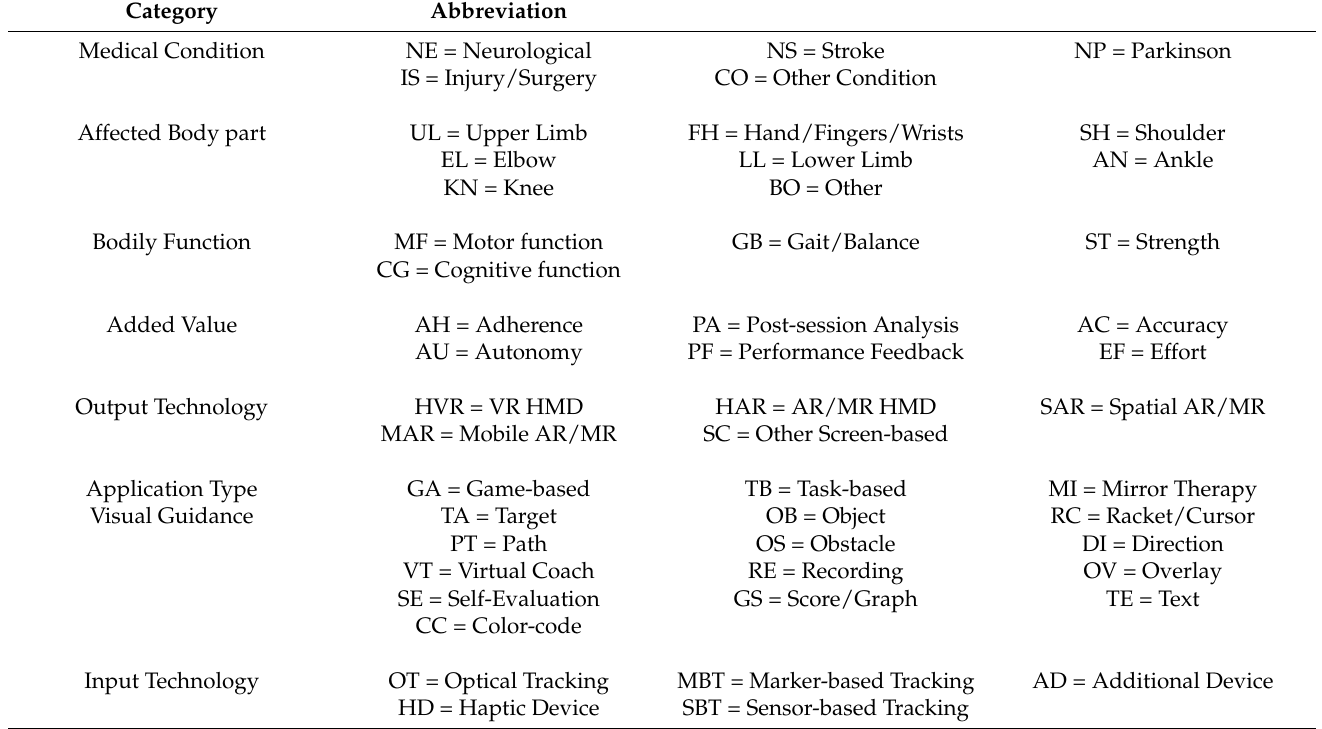
Table A7. Abbreviations for Tables